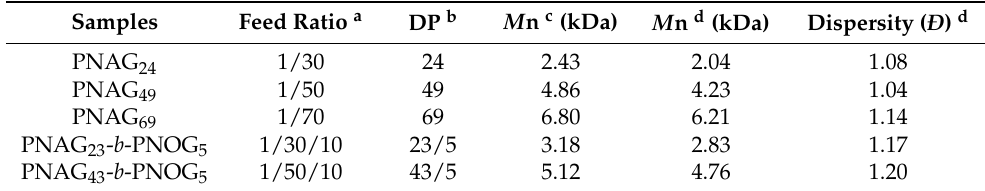
Table 1. Characteristics of the polymers